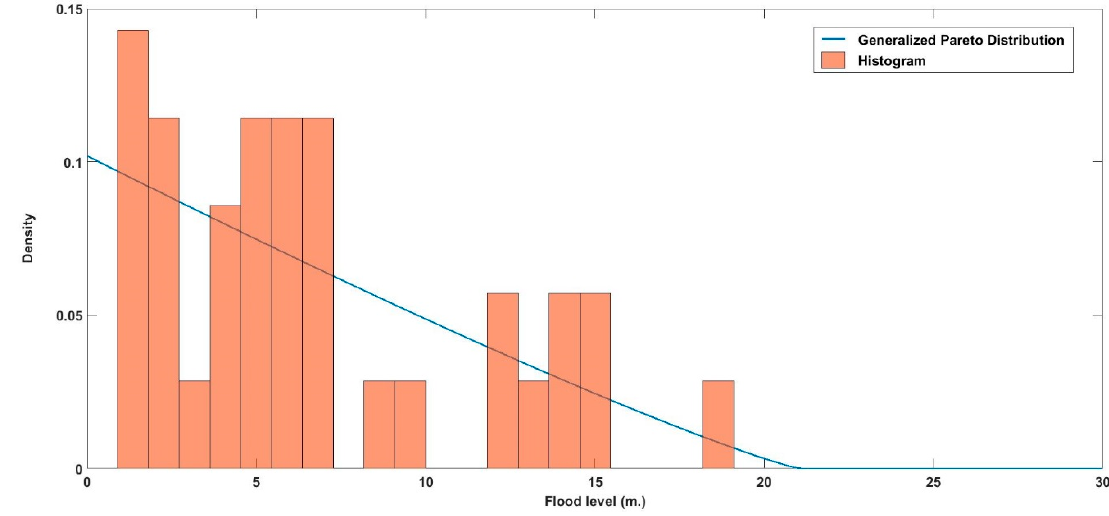
Figure 2. Flood level with generalized Pareto distribution.